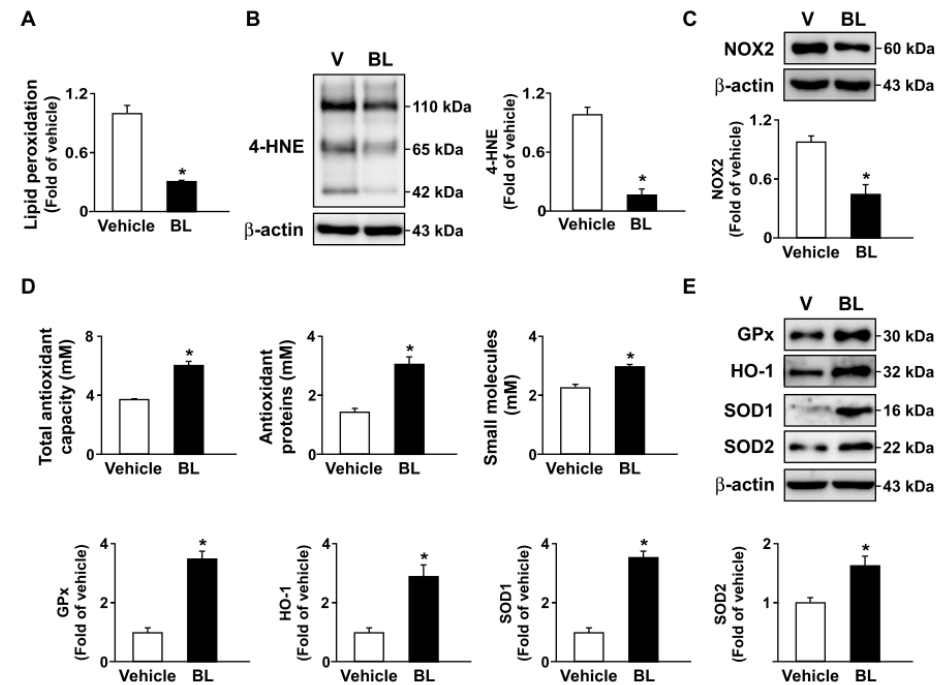
Figure 8. Bromelain decreases oxidative stress by increasing antioxidant capacity in the aortas of apoe −/− mice. Male apoe −/− mice were orally administered bromelain (BL, 20 mg/kg/day) or vehicle (PBS) for four weeks. ( A ) The aortic levels of lipid peroxidation of bromelain- or vehicle-treated apoe −/− mice. ( B , C ) Western blot analysis of 4-HNE, NOX2, and β -actin. ( D ) The levels of total antioxidant capacity, antioxidant proteins, and small molecules. ( E ) Western blot analysis of GPx, HO-1, SOD1, SOD2, and β -actin. * p < 0.05 vs. vehicle-treated apoe −/− mice.